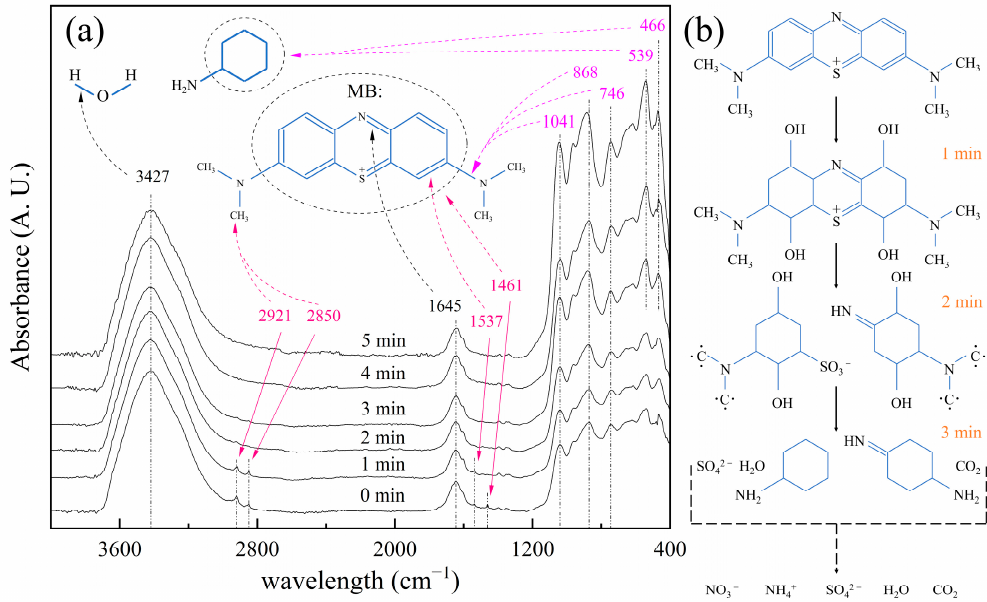
Figure 12. ( a ) In situ IR absorption spectra of MB solution at different time periods; ( b ) flow diagram of photocatalytic degradation of MB by MM-CaTiO 3 .